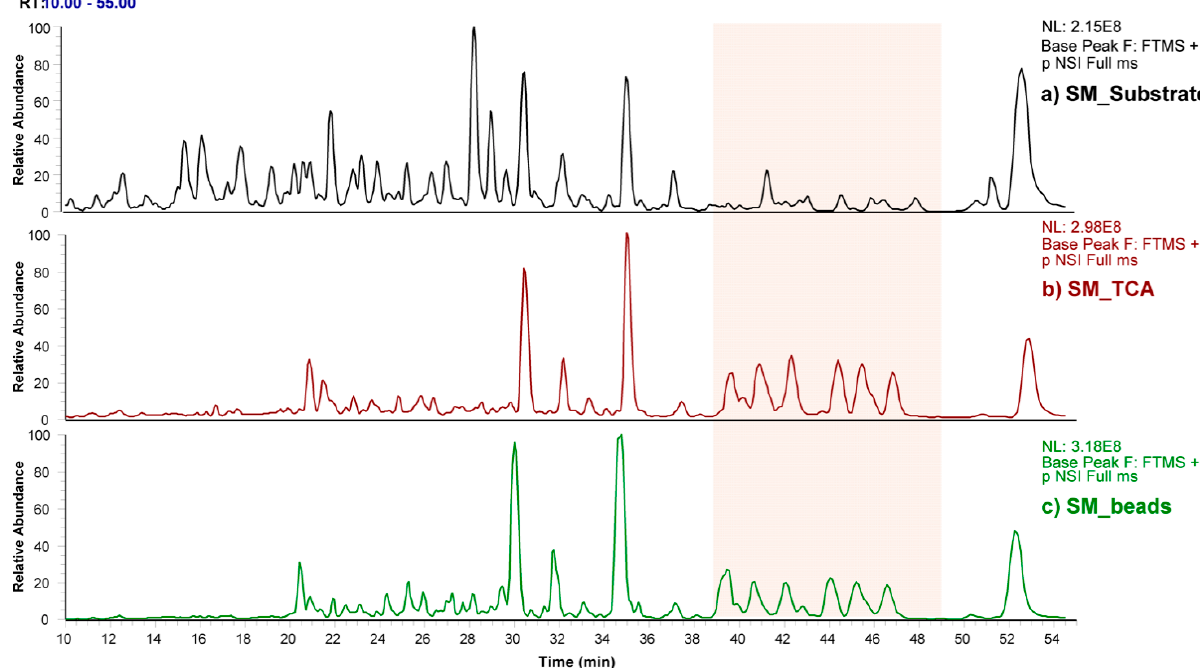
Figure 4. FTMS (Fourier Transform Mass Spectrometry)-Nanospray Ionization (NSI) spectrum: TIC (total ion current) zoomed into the separative gradient interval 10–55 min of SM-substrate, SM-TCA, and SM-beads samples acquired in data-dependent acquisition (DDA) mode. Light red square highlights the interval characterized by the greater diversity in terms of newly formed species due to the sample treatment.